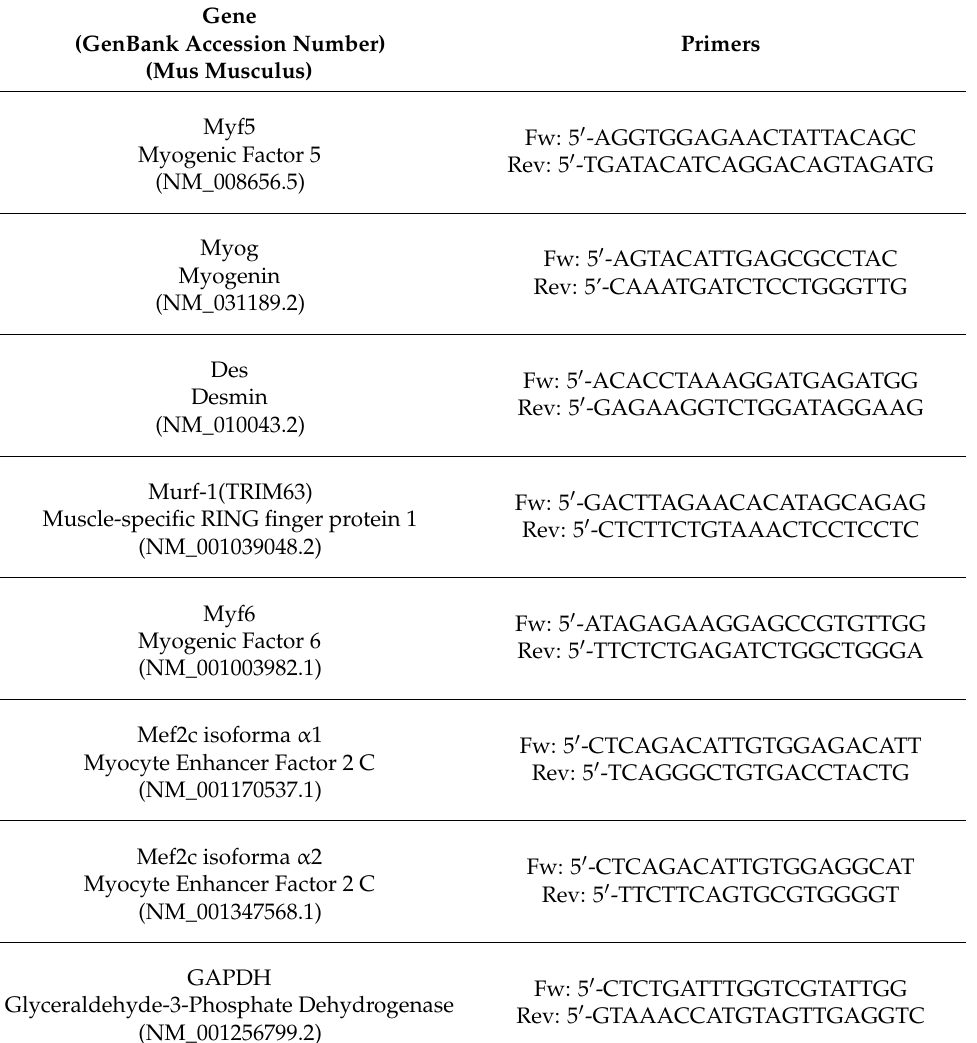
Table 1. Forward (Fw) and reverse (Rev) primers for real-time qPCR